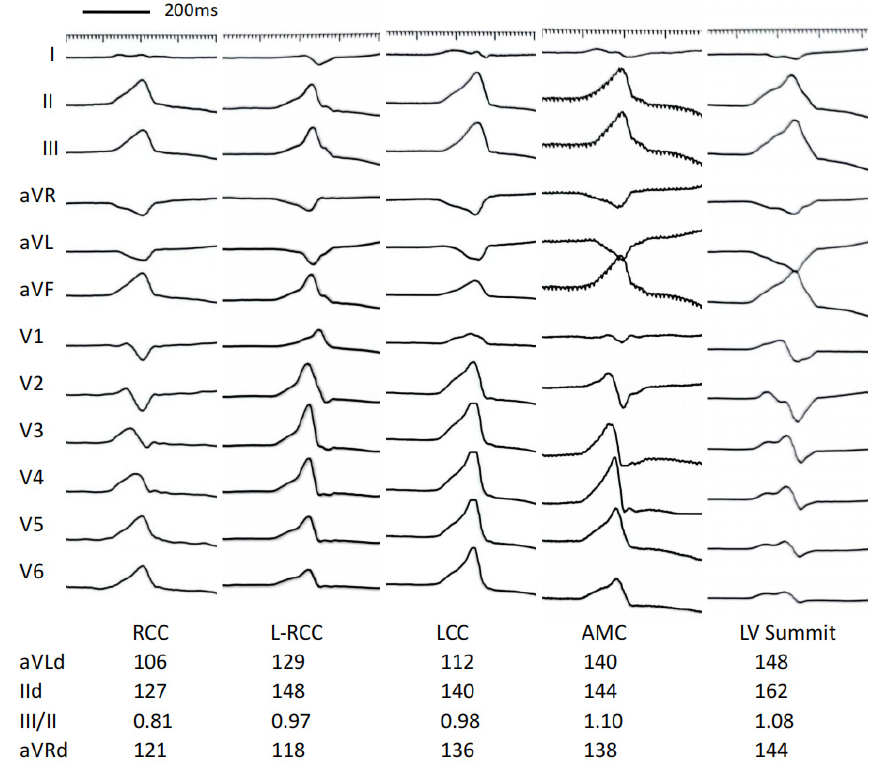
Figure 1. Examples of the electrocardiographic morphology of ventricular arrhythmias originating from different sites of LVOT. aVLd, The QS duration in aVL; IId, The R duration in II; III/II, The ratio of III/II; aVRd, The QS duration in aVR.